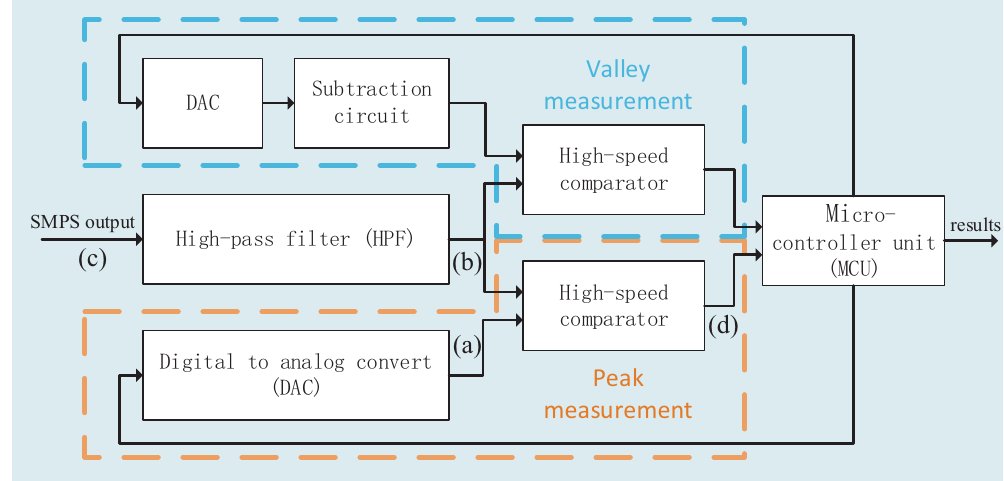
Figure 2. Block diagram of peak measurement and some inner